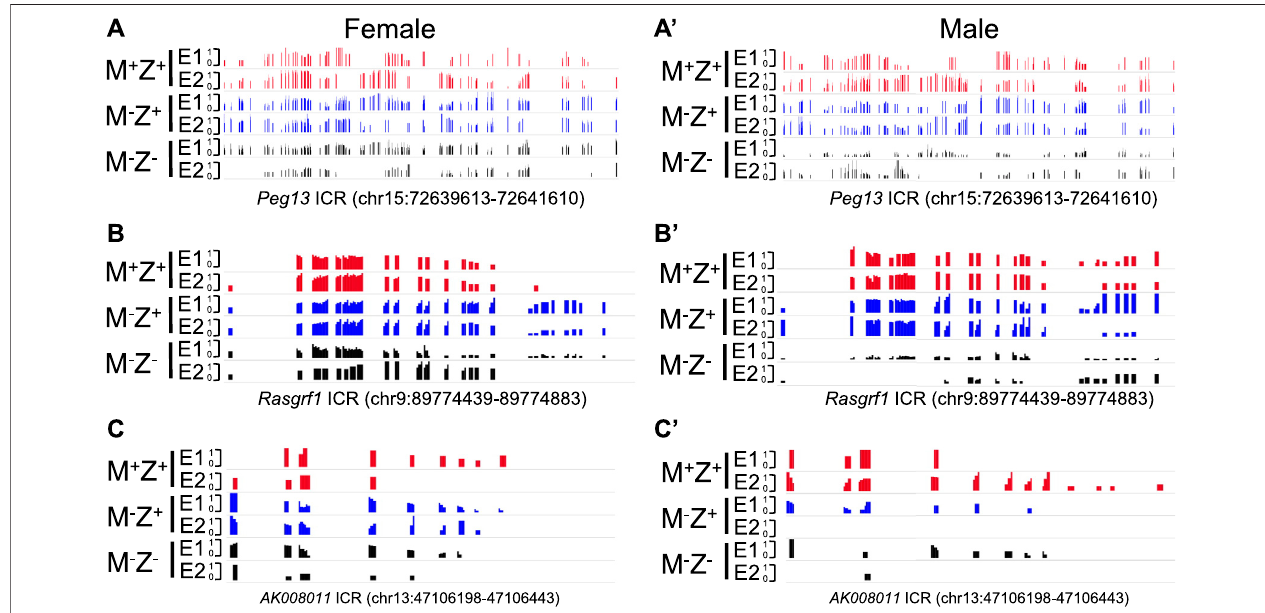
FIGURE 2 | Methylation level was lower at the Peg13 , Rasgrf1 , and AK008011 ICRs in male Zfp57 maternal – zygotic mutant embryos than that in the female ones on the methylation IGV plot. Genomic DNA samples were isolated from Zfp57 +/+ (M + Z + ), Zfp57 − /+ (M − Z + ), and Zfp57 − / − (M − Z - ) hybrid 129/DBA embryos that were generated from the timed mating as reported in the previous study (Jiang et al., 2021). They were subjected towhole-genome bisul fi te sequencing (WGBS) (Jiang et al., 2021).ThemethylationIGVplotwiththescaleof0 – 1isshownfortheICRsofthe Peg13 , Rasgrf1 ,and AK008011 imprintedregionsintwofemaleembryos(E1and E2) or two male embryos (E1 and E2) of the M + Z + , M − Z + , and M − Z - genotypes. (A,A ’ ) Methylation IGV plot of Peg13 ICR (mm9, chr15:72,639,613 – 72,641,610) in the female (A) or male (A ’ ) embryos. (B,B ’ ) Methylation IGV plot of Rasgrf1 ICR (mm9, chr9:89,774,439 – 89,774,883) in the female (B) or male (B ’ ) embryos. (C,C ’ ) Methylation IGV plot of AK008011 ICR (mm9, chr13:47,106,198 – 47,106,443) in the female (C) or male (C ’ ) embryos. There were no sequence reads at the AK008011 ICRintheE2sampleofmaleM − Z + in (C ’ ) .TherewereonlysixCpGsiteswithatleastthreeuniquereadsintheE2sampleoffemaleM − Z - in (C) andjusttwoCpGsiteswith at least three unique reads in the E2 sample of male M − Z - in (C ’ )